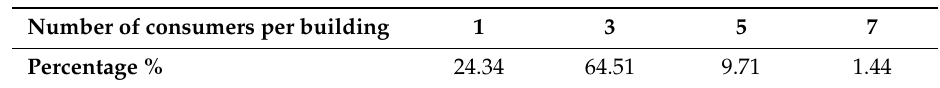
Table 7. DiNeMo input